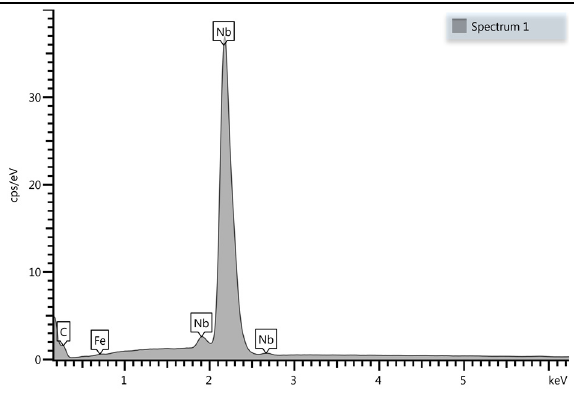
Figure 10. Energy spectrum obtained by EDS from the visible niobium carbide precipitates.